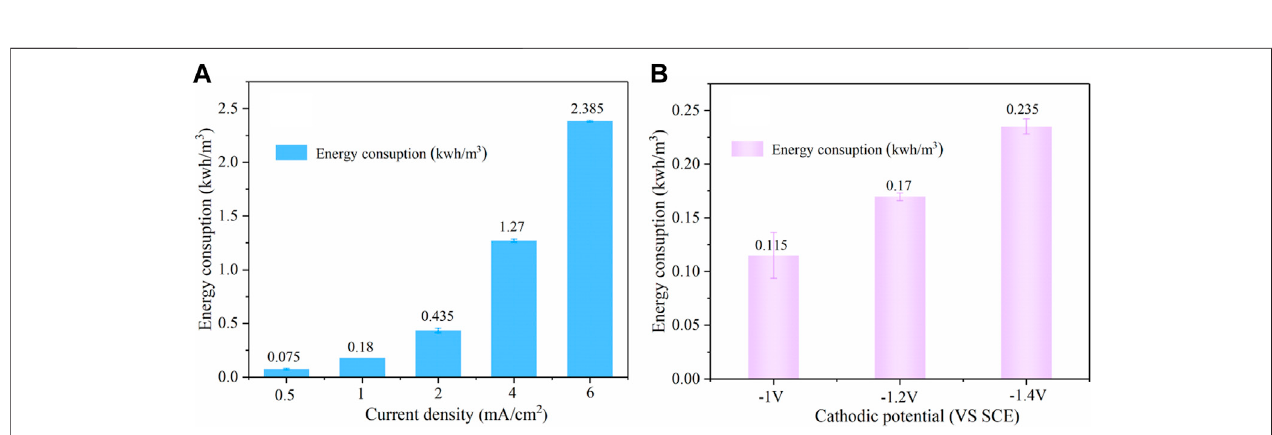
FIGURE 11 | Effect of different current densities (A) and cathodic potential (B) on energy consumption (PNP (cid:1) 100 mg/L, Na 2 SO 4 (cid:1) 3 g/L, pH 0 (cid:1) 7.0).